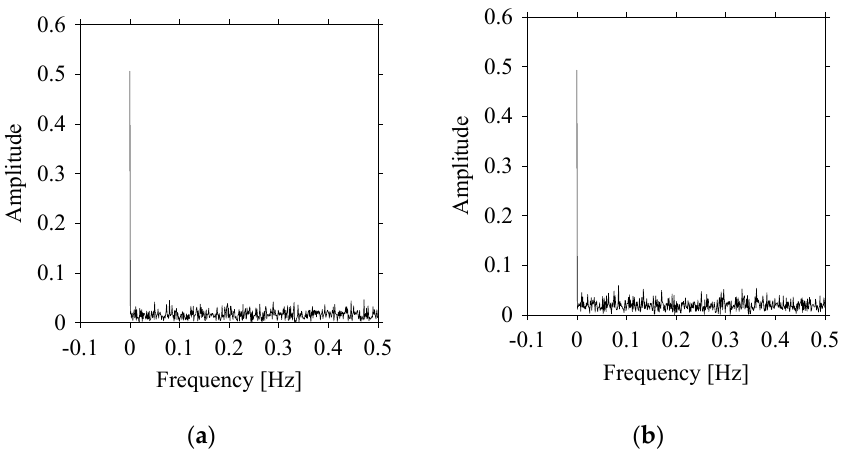
Figure 4. Quantifying S 1 and S 2 in the frequency domain. ( a ) The frequency domain of S 1 . ( b ) The frequency domain of S 2 .